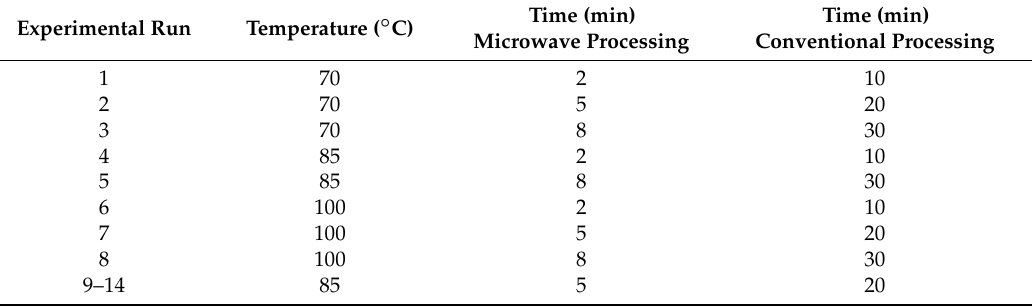
Table 3. Central composite design showing different combinations of temperature and time for processing of